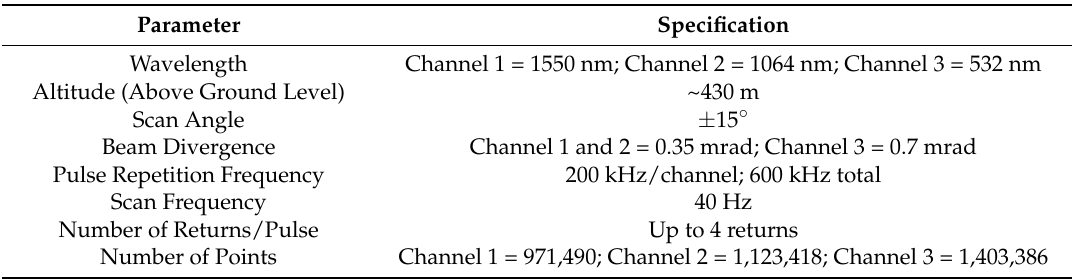
Table 1. Data specifications.